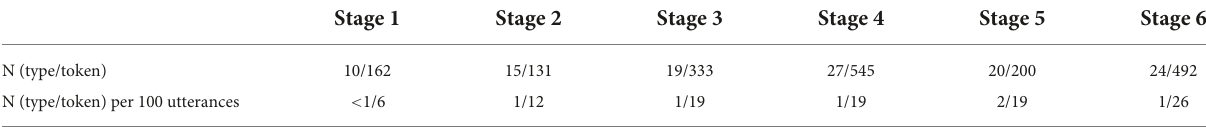
TABLE 5 The number of verbalizers (N type/token) and the number of verbalizers per 100 utterances (N type/token), by stage. Stage 1 Stage 2 Stage 3 Stage 4 Stage 5